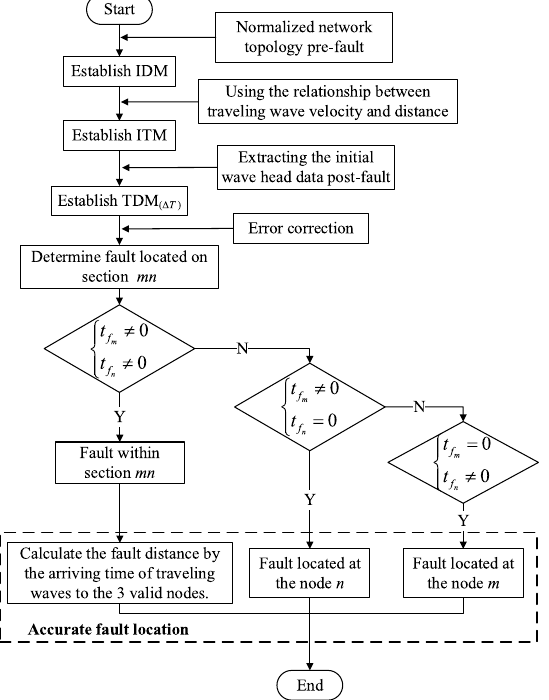
Fig. 1 Flowchart of fault location method under ideal detection device configuration Fig. 2 Simple distribution network